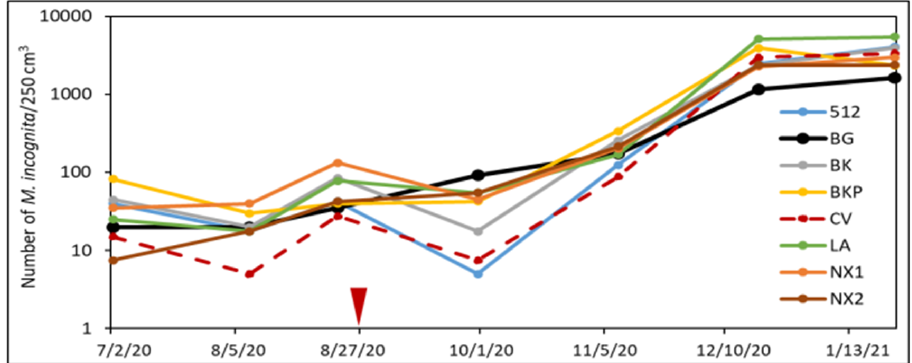
Figure 6. Number of Meloidogyne spp. ( n = 4) juveniles in the soil at each sampling date from sorghum/sorghum–sudangrass cover crop plots throughout cover cropping and eggplant growing period in a no-till field trial.